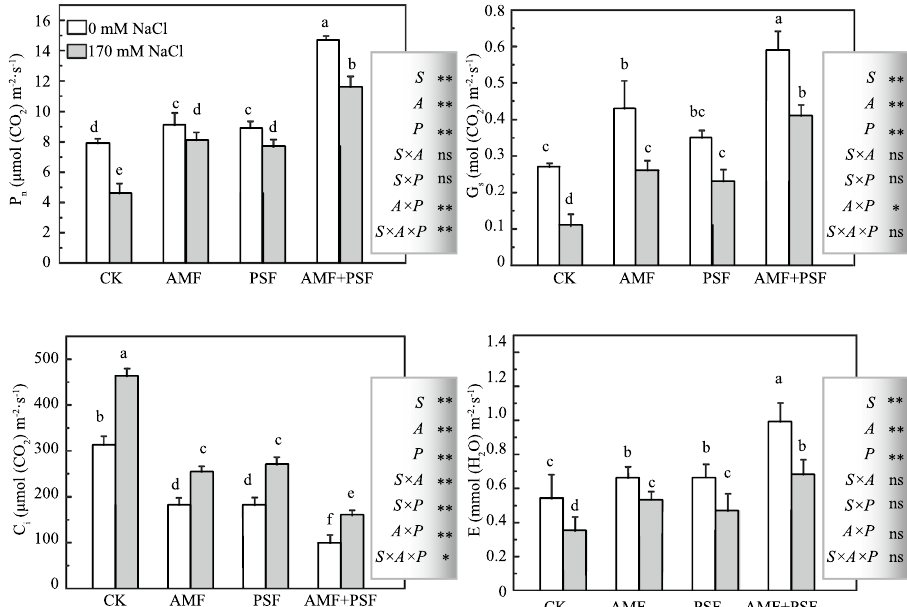
Figure 2. Effects of F. mosseae and/or A. spartima on the photosynthetic parameters of beach plum under saline and non-saline conditions. Net photosynthetic rate ( P n ), intercellular CO 2 concentration ( C i ), stomatal conductance ( G s ), and transpiration rate ( E ). The values of each parameter labeled by different letters indicate significant differences assessed by Duncan’s test after performing a three-way MANOVA ( p < 0.05). ns non- significant; *significant at p < 0.05; **significant at p <